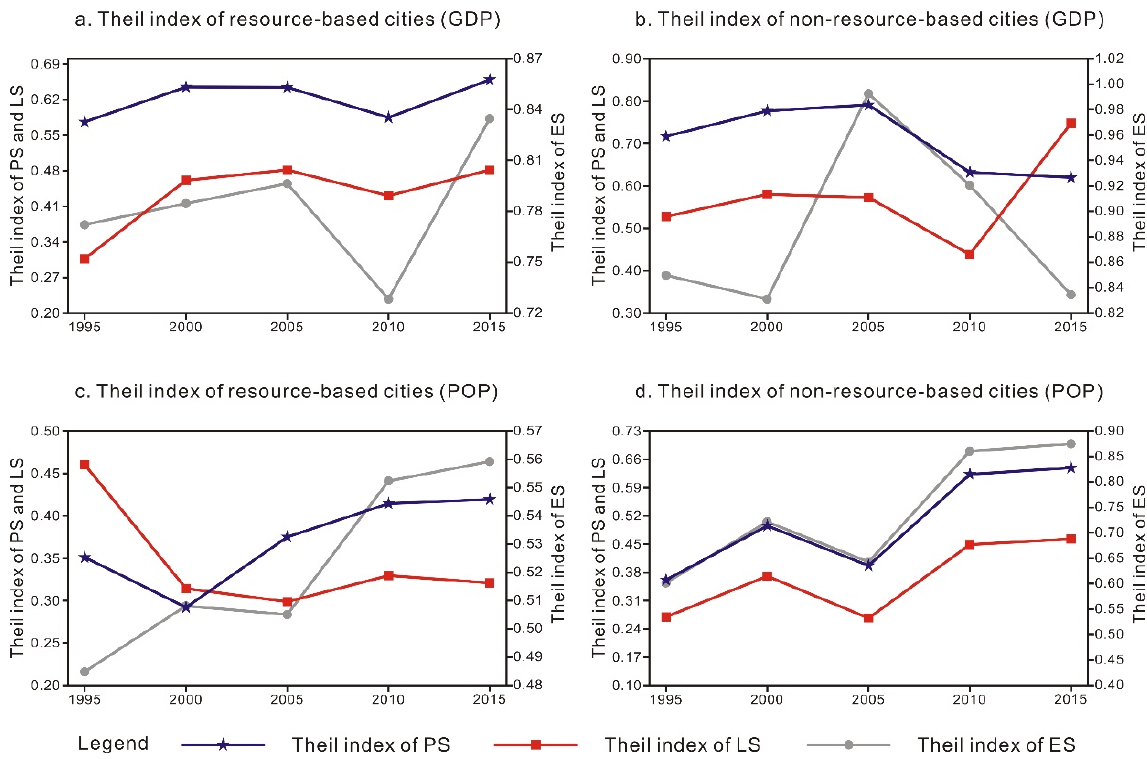
Figure 5. Change trend of the PLES-related Theil index of the two types of cities, 1995–2015. Note: The left ordinate indicates the PS and LS, and the right ordinate indicates the ES.